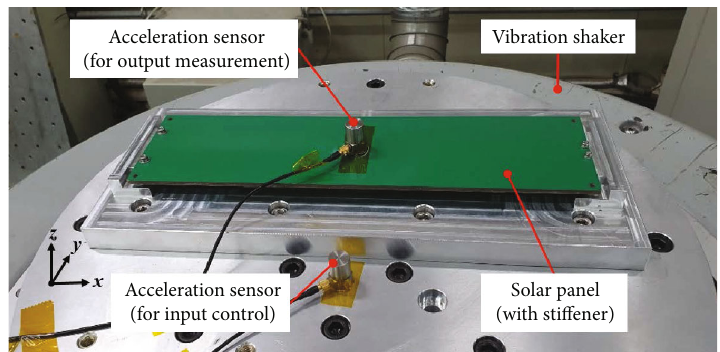
Figure 9: Launch vibration test setup con fi guration of the solar panel.